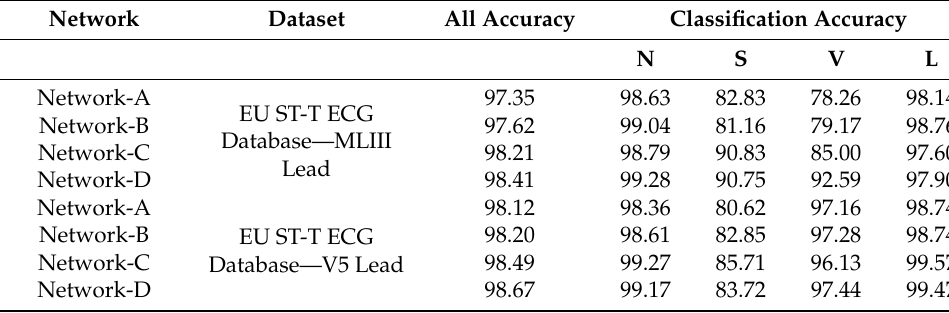
Table 4. Test results of all networks on type II